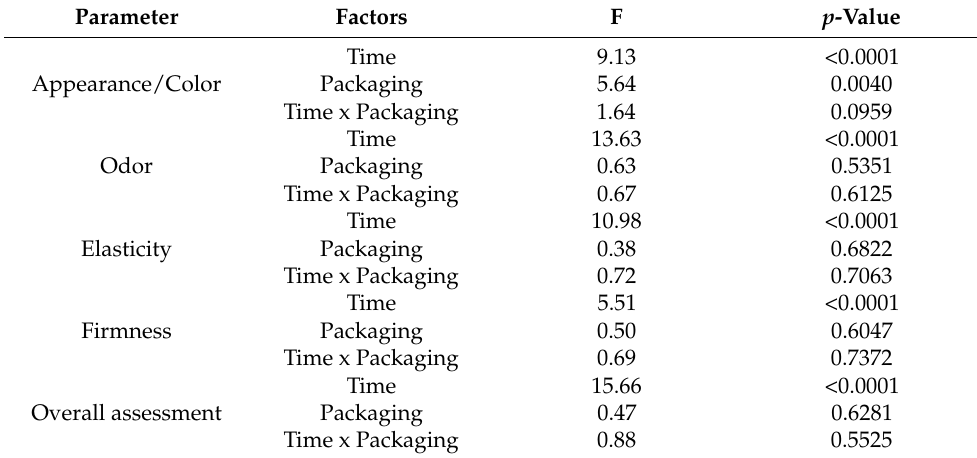
Table 4. Results of ANOVA per sensory parameter considering factors time (0, 1, 5, 8, 12, and 15 days) and packaging (AIR, VP, and